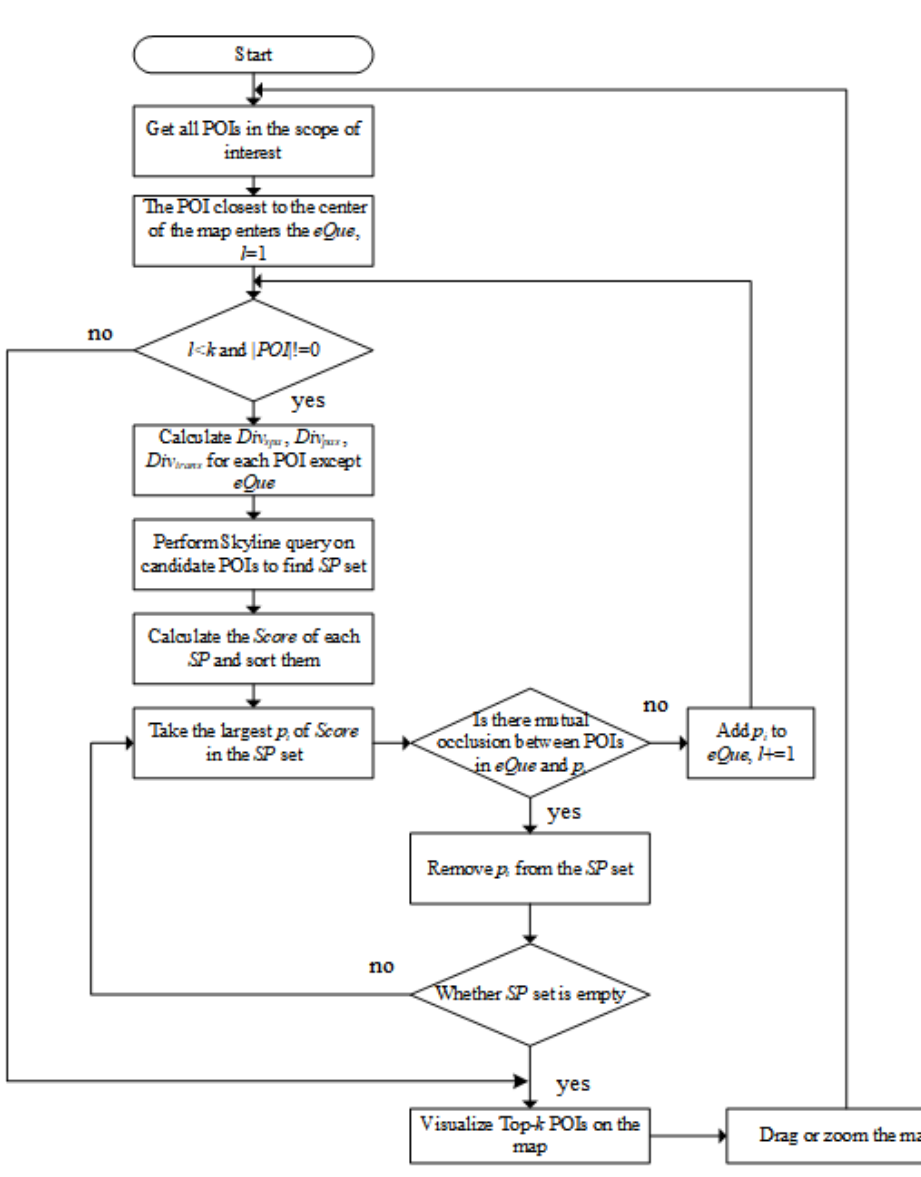
Figure 5. Flow chart of Skyline-based top-k